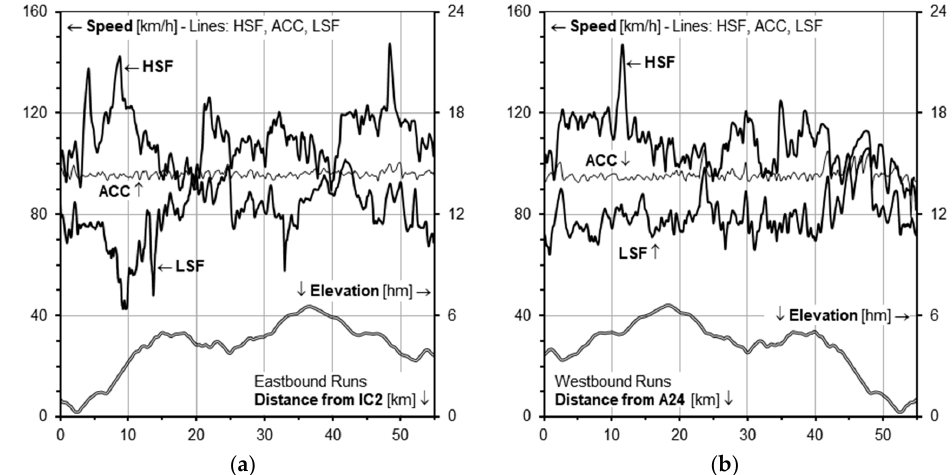
Figure 7. Speed profiles of the driving protocols LSF (low speed filtered), HSF (high speed filtered); and ACC (adaptive cruise control), for the: ( a ) eastbound runs; ( b ) westbound runs.